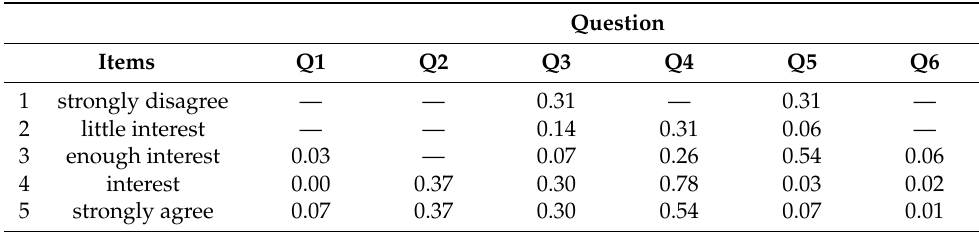
Table 11. Results of test of proportions between girls aged ≥ 12 and boys aged ≥ 12.